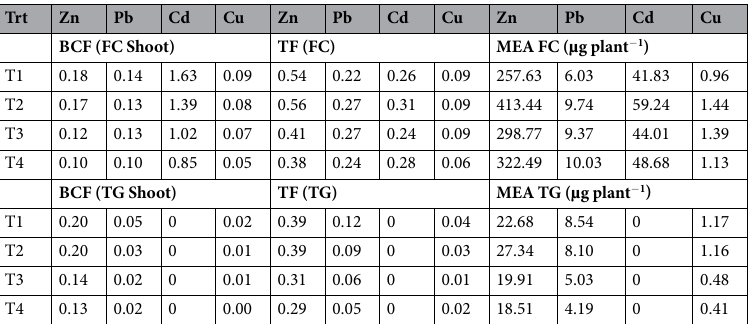
Table 2. Effect of bamboo biochar on the Bioconcentration Factor (BCF), Translocation Factor (TF) and Metal Extraction Amount (MEA) of Brassica juncea grown in FC and TG soil. * Values indicate mean of one sample with three replications. (T1 = Control, T2 = 1.0% BB, T3 = 2.5% BB, T4 = 5.0%